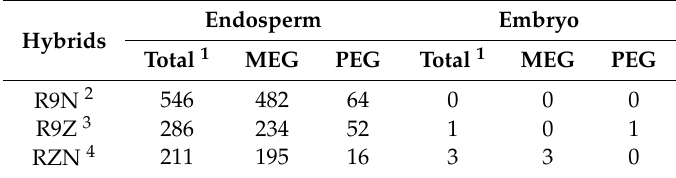
Table 2. Summary of imprinted genes identified in three sets of reciprocal